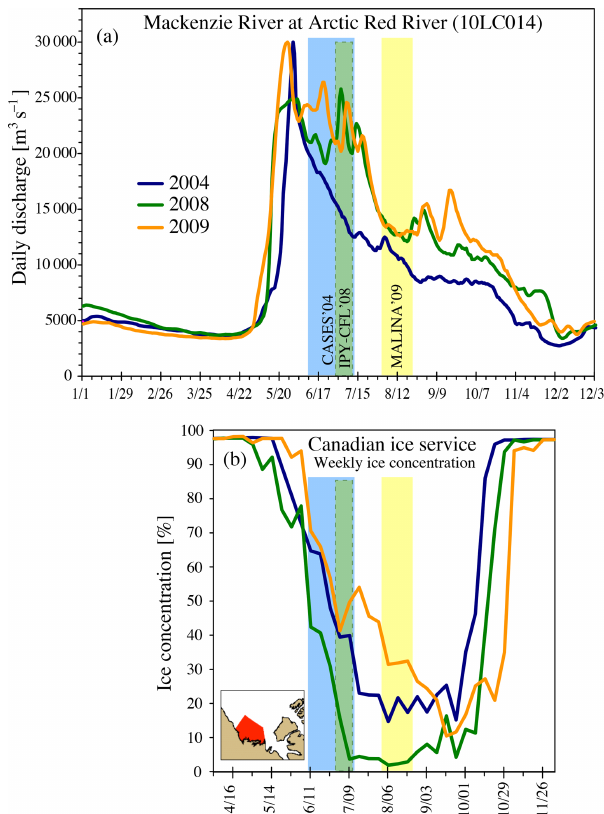
Figure 10. (a) Daily discharge for the Mackenzie River at the Arc- tic Red River location (10LC014). Data obtained from Environment Canada. (b) Weekly ice coverage for the Mackenzie Shelf area cal- culated using IceGraph 2.0 provided online by the Canadian Ice Service. The distributions of sea ice types are provided in Fig. S4. Time periods for the three expeditions considered in this study are also indicated in color shades. The x -axis labels are dates expressed in the format of month/day and are spaced 4 weeks